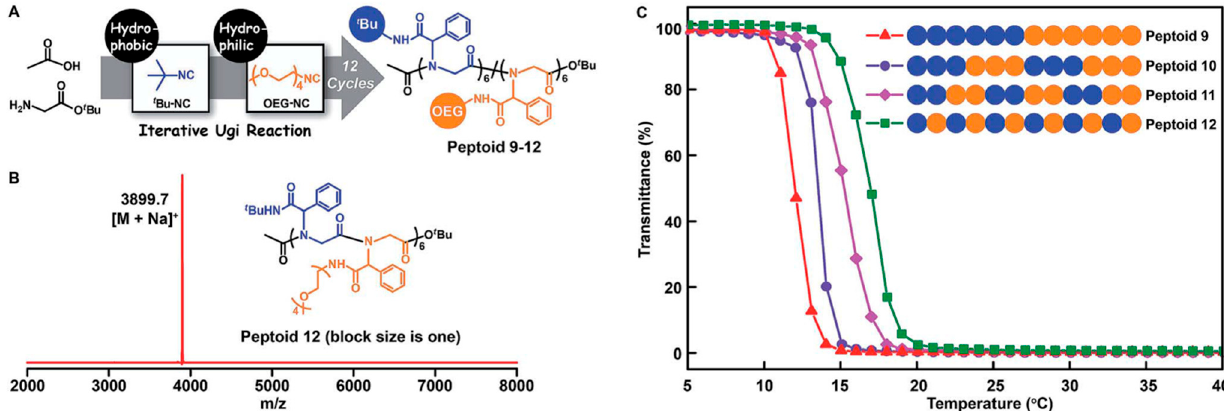
Figure 20. ( A ) Illustration of the side-chain sequence-regulated OEGylated poly(amino acid)s 9–12 synthesized by iterative Ugi reactions. ( B ) MALDI-TOF-MS spectrum of 12. ( C ) Temperature dependence of transmittance for the aqueous solutions (2 mg/mL) of sequence-regulated OEGylated poly(amino acid)s 9–12 (500 nm, heating at a rate of 1 °C/min). Reproduced with permission [40]. Copyright 2019, Royal Society of Chemistry.